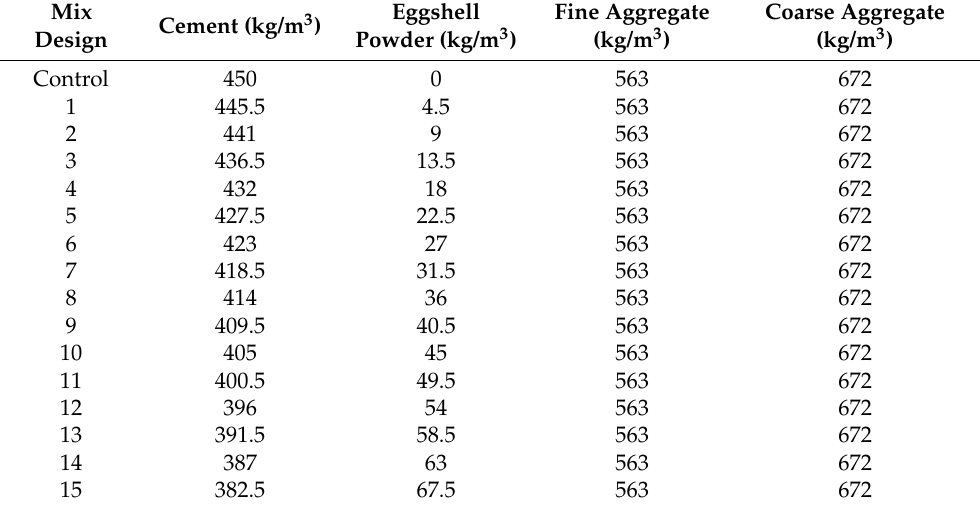
Table 4. Concrete mix design.